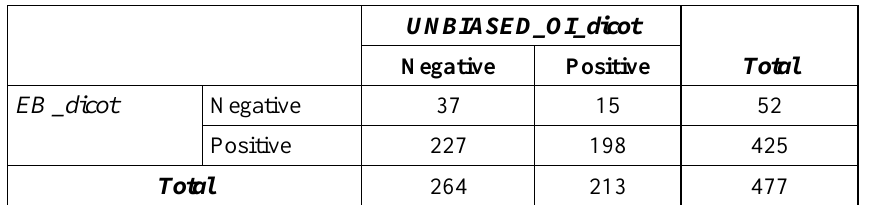
Table 2. Contingency table for dichotomized EB and OI ( n = 477)